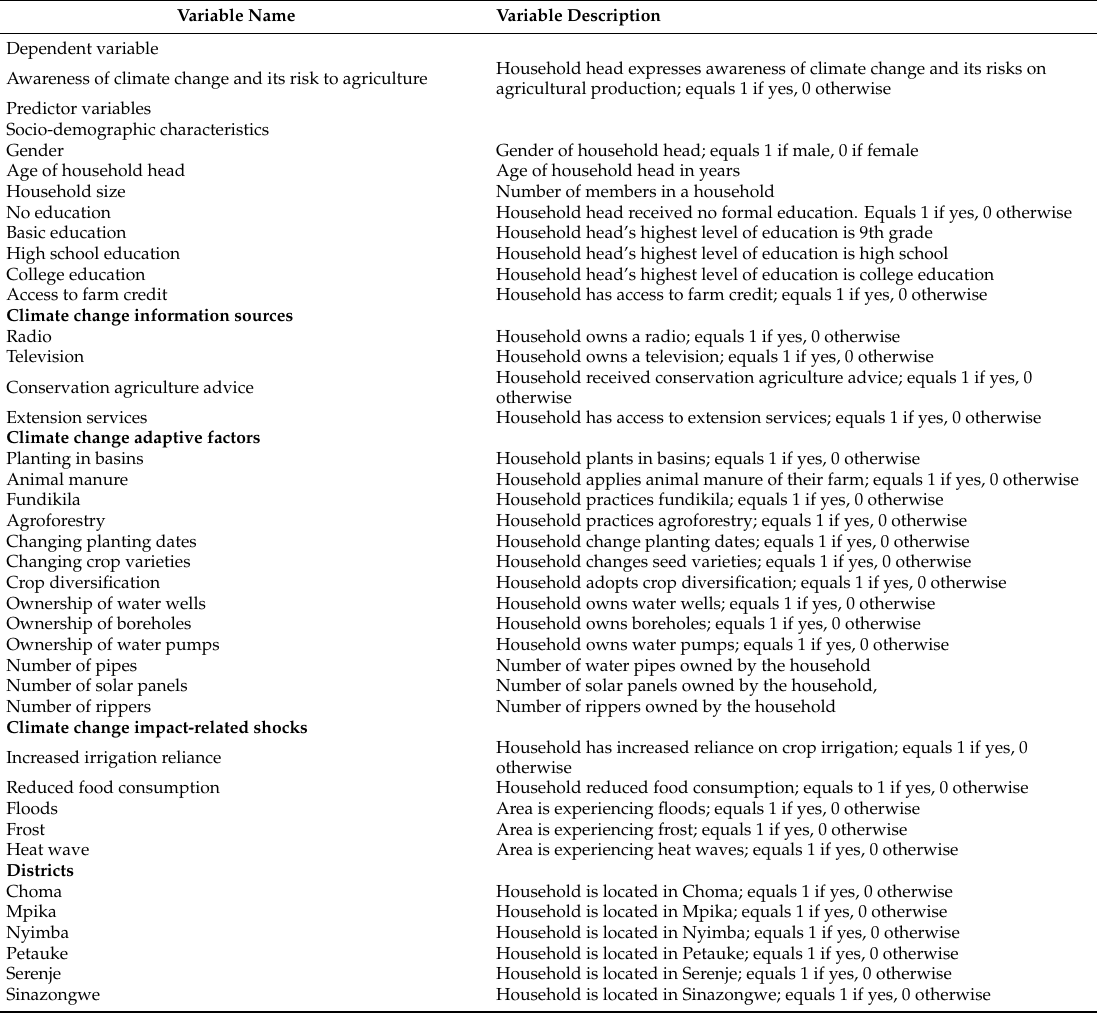
Table 1. Definition of